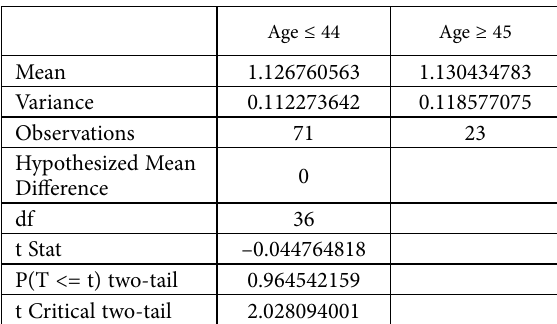
Table 3. Usability by age